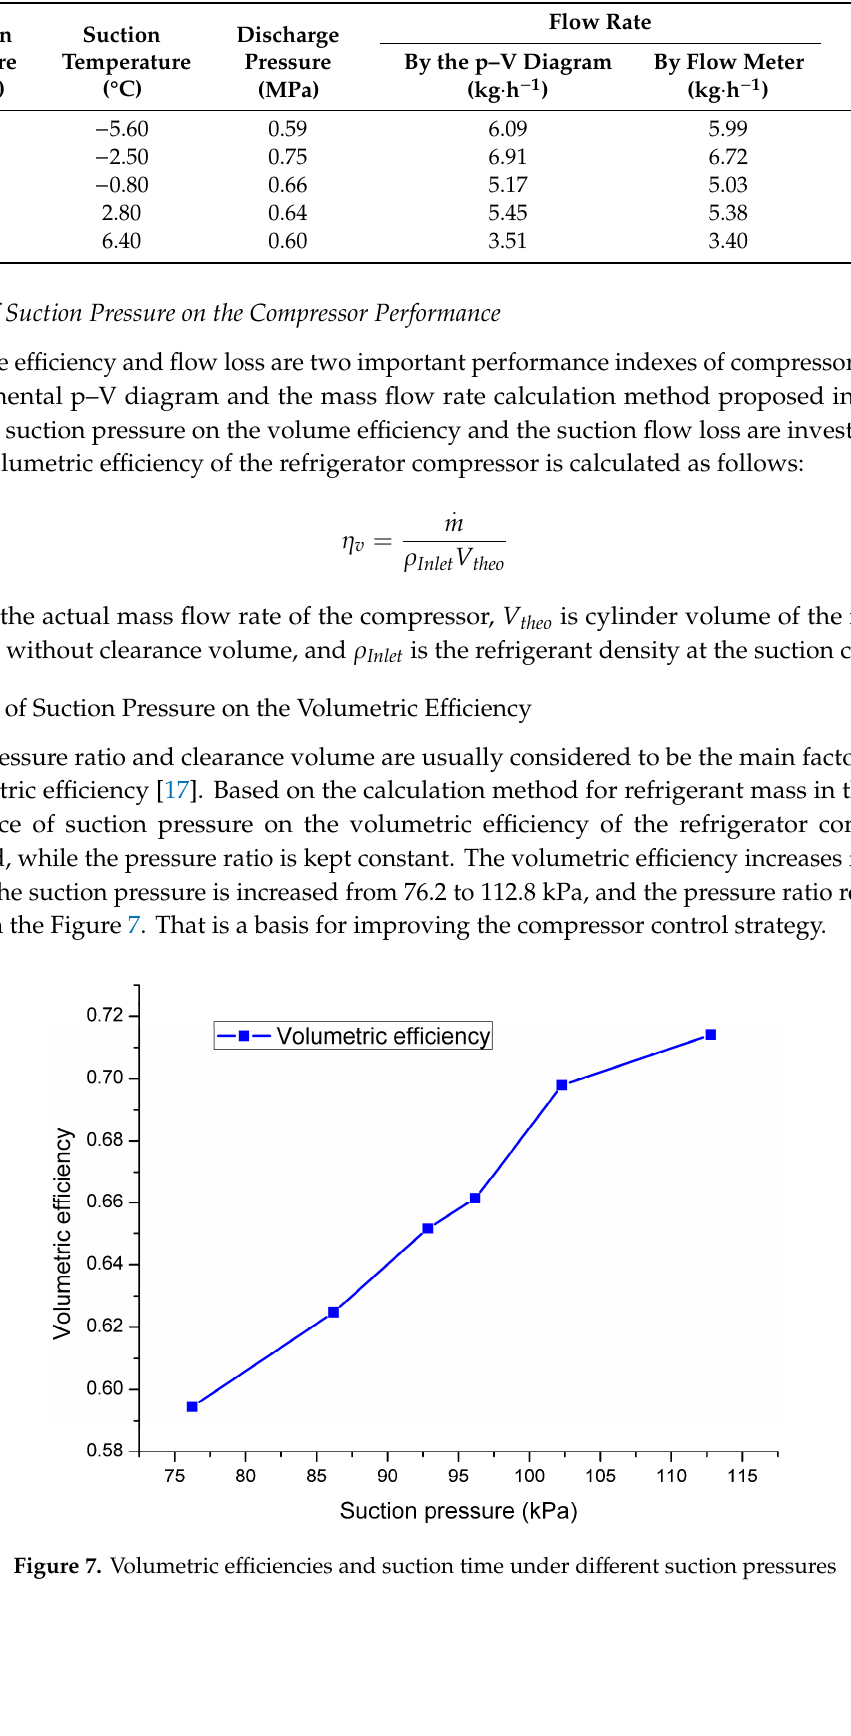
Table 3. The comparison of the experimental and calculated flow rate.